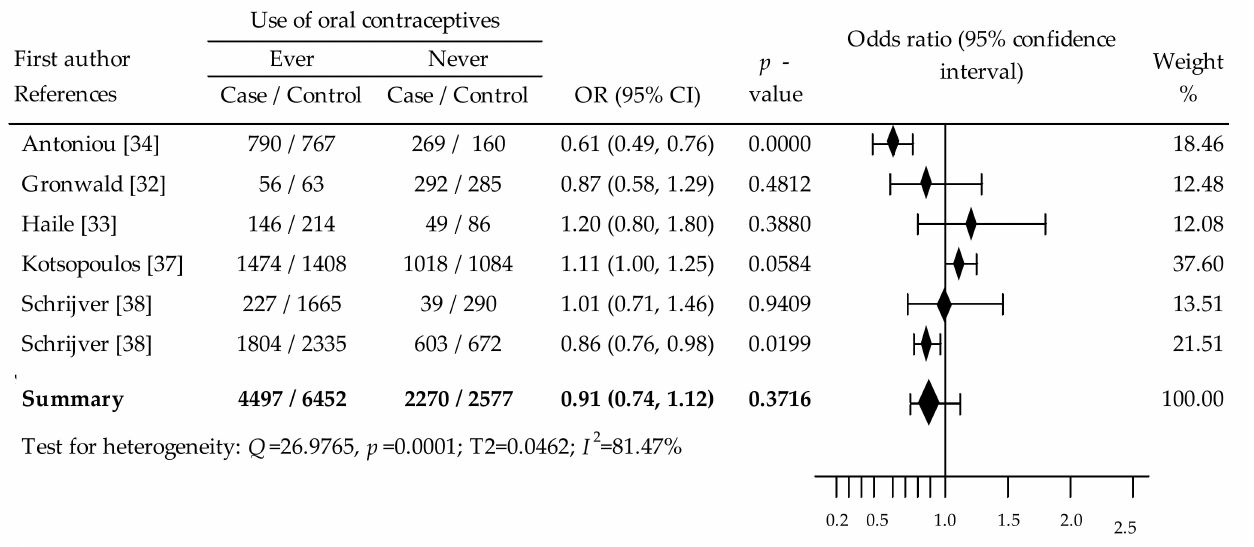
Figure 3. Forest plots for association between oral contraceptives and breast cancer in BRCA1 mutation carriers [32–34,37,38]. Note: data are expressed as mean differences with 95% CIs, using random effects models; effect is represented by the block diamond; the horizontal lines denote the 95% CIs, some of which extended beyond the limits of the